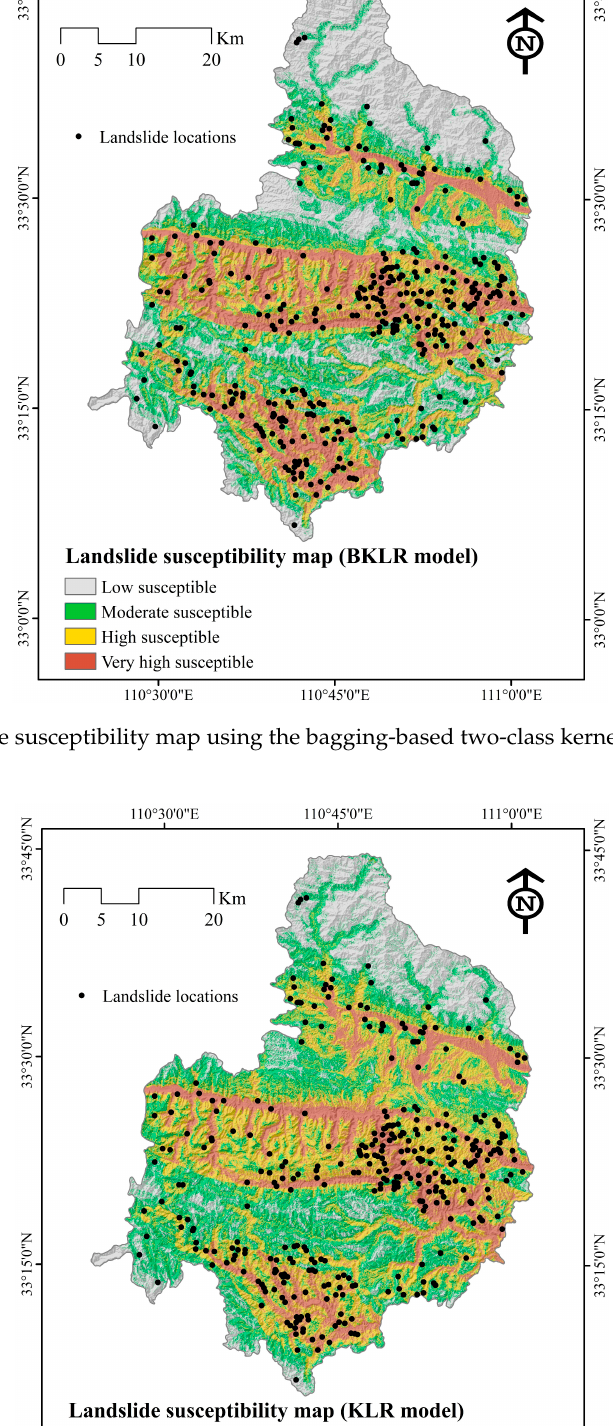
Figure 7. Landslide susceptibility map using the support vector machines (SVM) model.